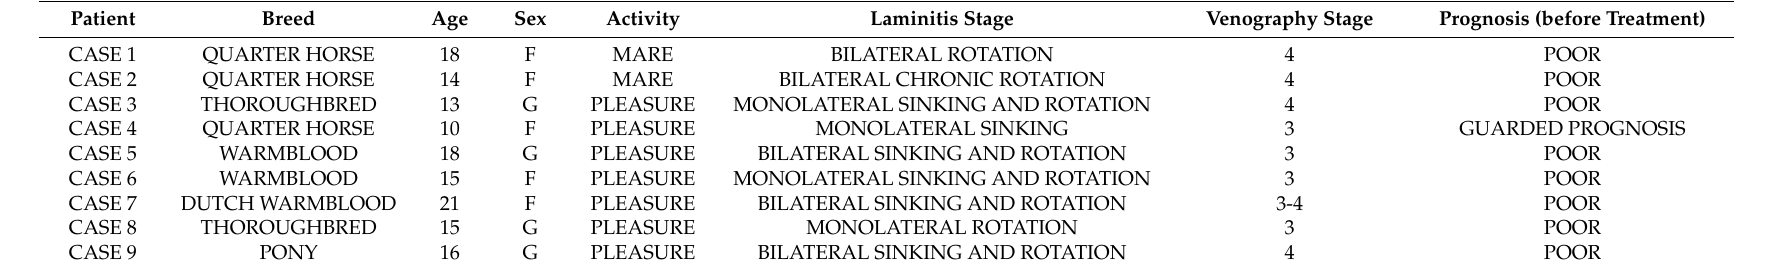
Table 3. Description of clinical cases enrolled in the study. Legend: F = female; G =